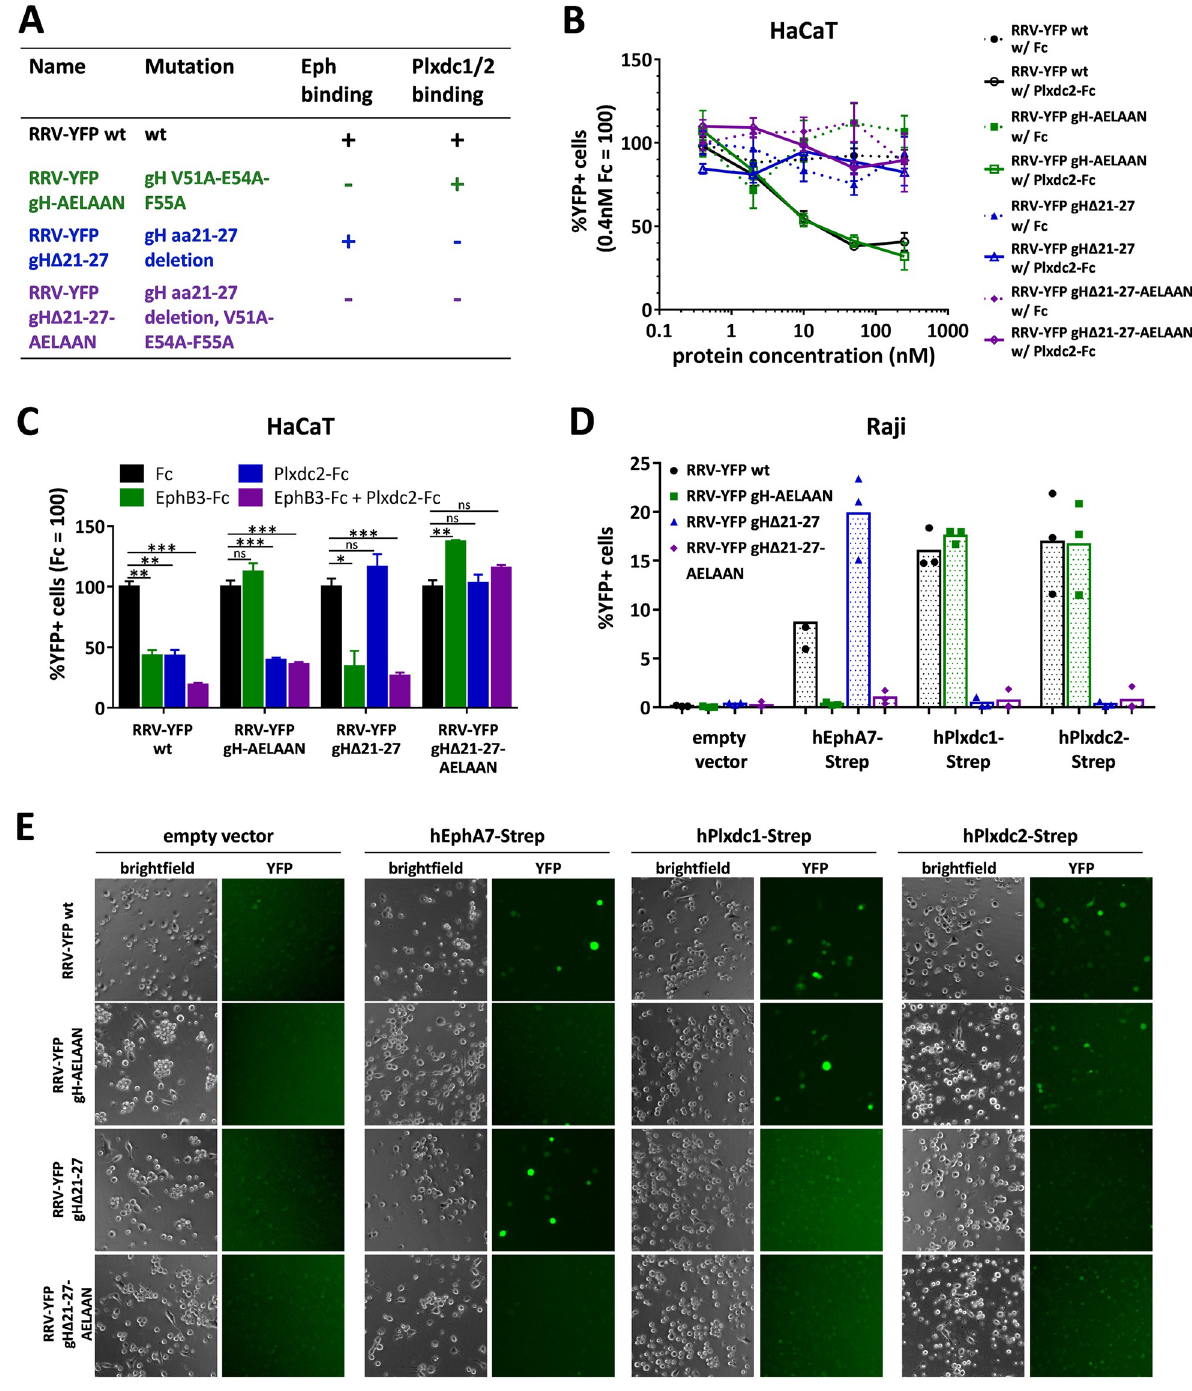
Fig 4. Deletion of the seven amino acid Plxdc-binding motif is sufficient to detarget RRV 26–95 from Plxdc receptors. A) List of BAC-derived recombinant viruses and introduced mutations used in this figure. B) Dose-dependent inhibition of RRV 26–95 infection by soluble human Plxdc2-FcStrep on HaCaT cells. RRV-YFP wt, RRV-YFP gH-AELAAN, RRV-YFP gH Δ 21–27 and RRV-YFP gH Δ 21-27-AELAAN were pre- incubated with hPlxdc2-FcStrep for 30min at room temperature. FcStrep alone was used as control. YFP expression as indicator of infection was measured by flow cytometry. Infection in the presence of 0.4nM FcStrep was set to 100% (MOI ~0.05, triplicates, error bars represent SD). C) Inhibition of RRV 26–95 infection by soluble Plxdc2-FcStrep and EphB3-Fc on HaCaT cells. RRV-YFP wt, RRV-YFP gH-AELAAN, RRV-YFP gH Δ 21–27 and RRV-YFP gH Δ 21-27-AELAAN were pre-incubated with 100nM hPlxdc2-FcStrep, 10nM EphB3-Fc or a combination of 100nM hPlxdc2-FcStrep and 10nM EphB3-Fc for 30min at room temperature. FcStrep alone was used as control. YFP expression as indicator of infection